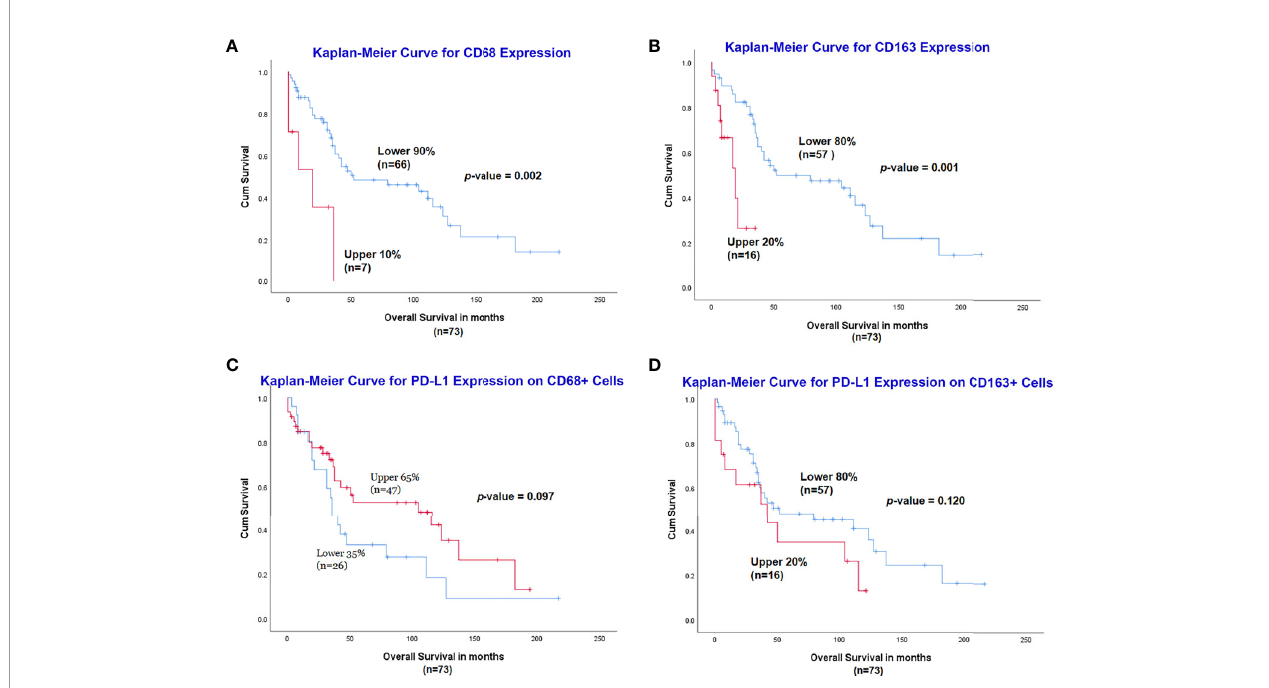
FIGURE 4 | Assessment of CD68, CD163 and PD-L1 expression with multiplexed quantitative immuno fl uorescence analysis. Lower expression of CD68 (A) and CD163 (B) was associated with a signi fi cantly better outcome. Increased expression of PD-L1 on CD68+ cells had a slightly better OS (C) , while the high expression of PD-L1 on CD163+ cells was related to inferior prognosis (D) , although both were not statistically signi fi